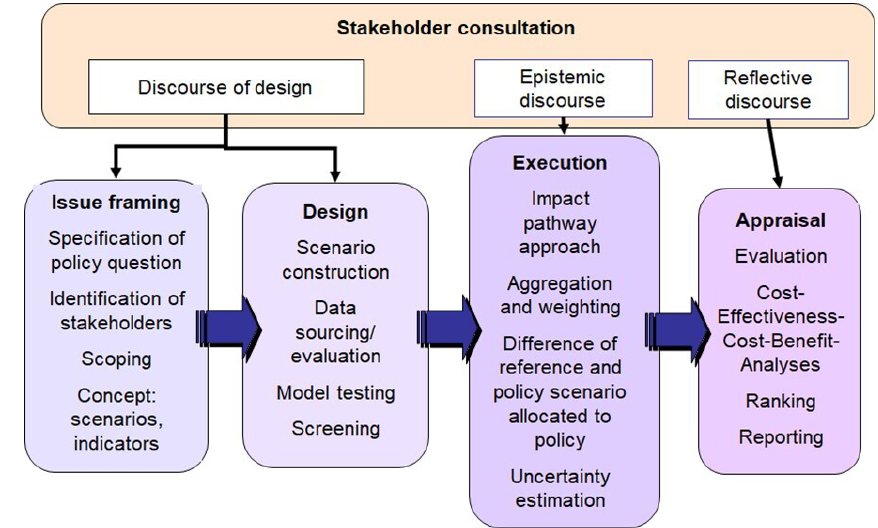
Figure 18. Integrated assessment process involving air pollution (Briggs, 2008).